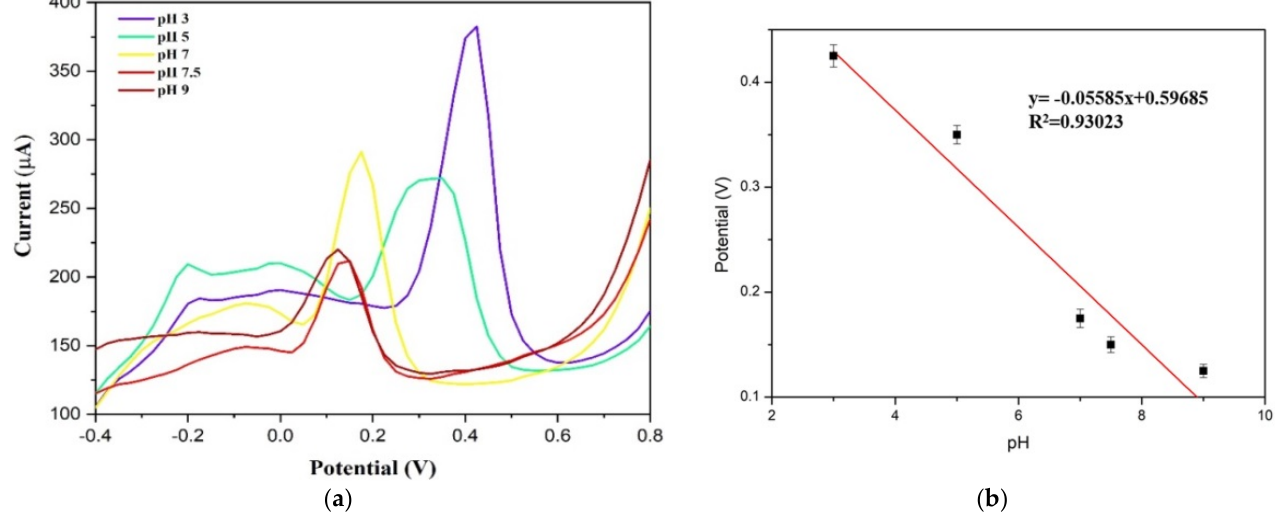
Figure 9. ( a ) DPV curve for various pH values. ( b ) Plot of the oxidation peak potentials versus the pH values.